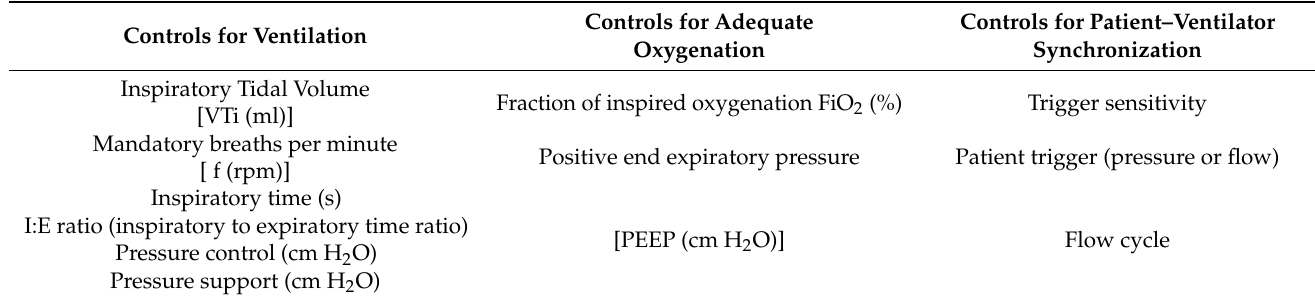
Table 2. Control parameters to be set in a